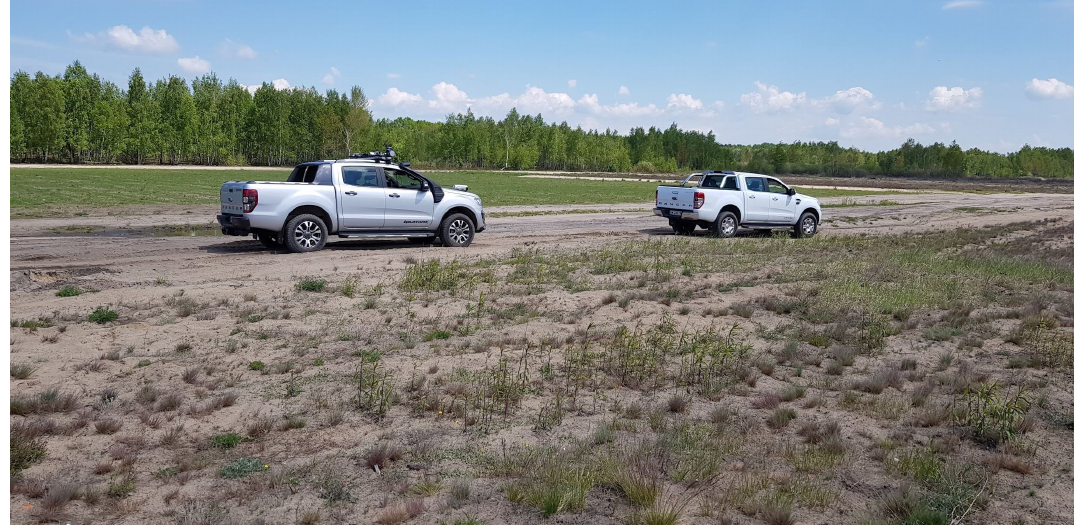
Figure 3. Łukasiewicz-PIAP ATENA demonstrator of technology in unstructured